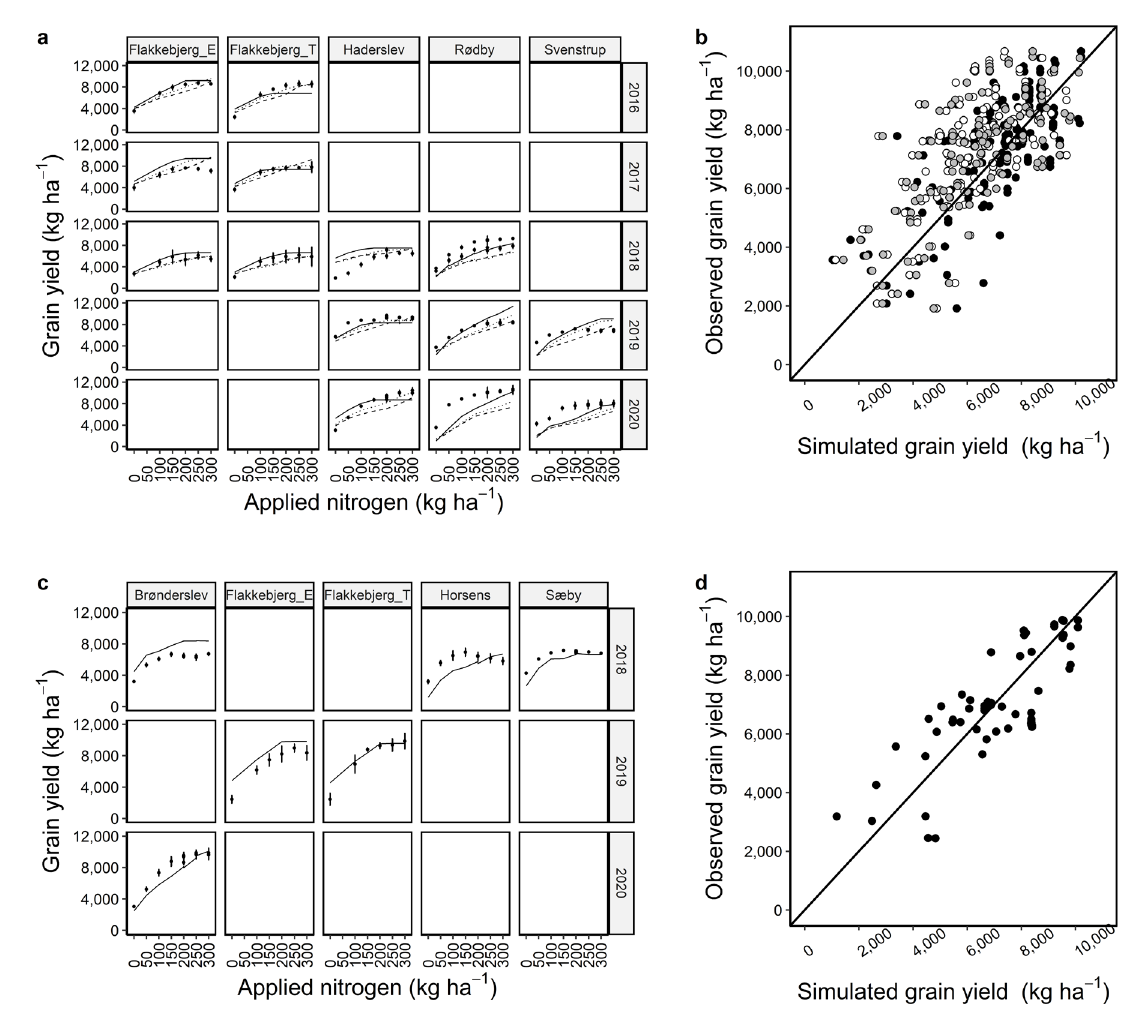
Figure 4. Calibration ( a , b ) and evaluation ( c , d ) of APSIM winter wheat grain yield under 7–13 nitrogen management scenarios. Coloured circles are observed data points and solid, dashed, and dotted lines are model outputs with Dan_winter, default, and modified cultivars, respectively ( a , c ). Black, white, and grey circles represent model outputs using Dan_winter, default, and modified cultivars, respectively ( b , d ). Diagonal black lines in b and d are 1:1 lines. Discontinuous lines (e.g., Brønderslev and Sæby) at > 200 kg N application indicate the simulations output with single dose or split applications of N at the locations in the same year (Table S1). For Rødby in 2018, discontinuous line also indicated two simulations with different sowing dates.